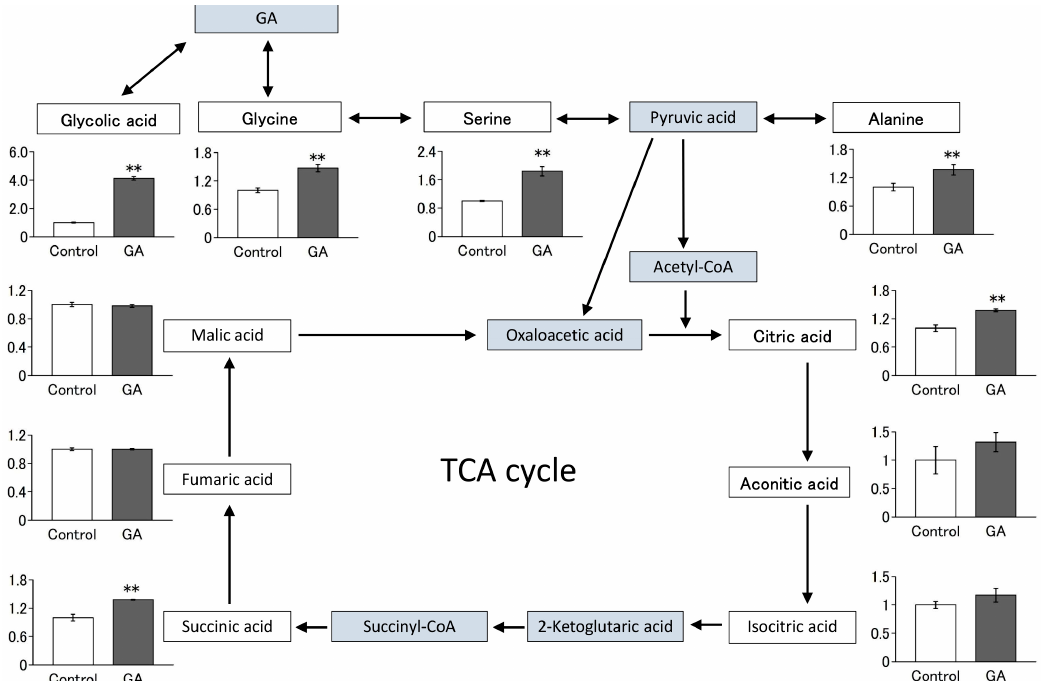
Figure 4. Changes in the intracellular content of several amino acids and their metabolites caused by GA. C2C12 cells grown to subcon fl uence in a growth medium (without GA) were further cul- tured in a di ff erentiation medium with or without GA for 6 d. Relative metabolite changes shown in the graphs were obtained using GC-MS analysis. Values are presented as mean ± SD of three independent experiments. Statistical differences were determined using Student’s t -test. Differences with ** p < 0.01 was considered